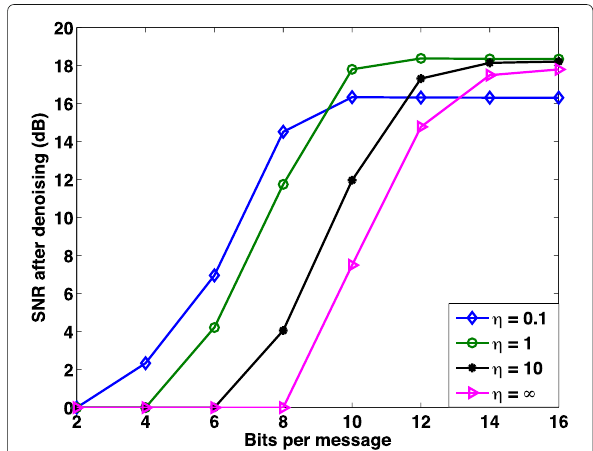
Fig. 6 Denoising performance (in dB) versus bits per message using dictionaries learned with different values of η . The SNR of the input signals is 10 dB